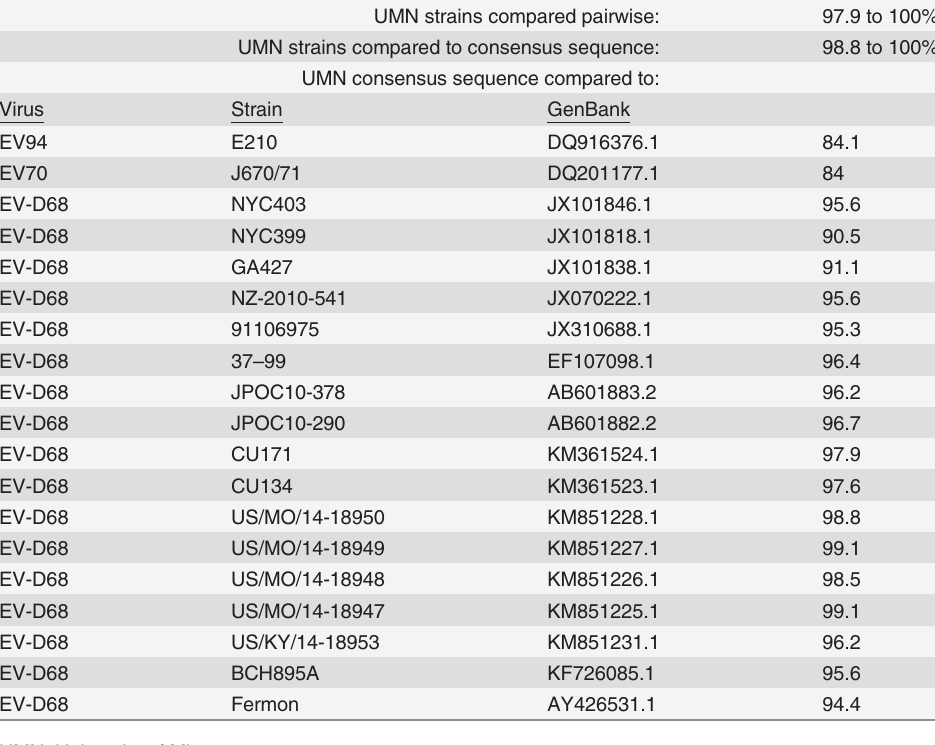
Table 2. Percent 5'-UTR Fragment Sequence Identity. UMN strains compared pairwise: 97.9 to